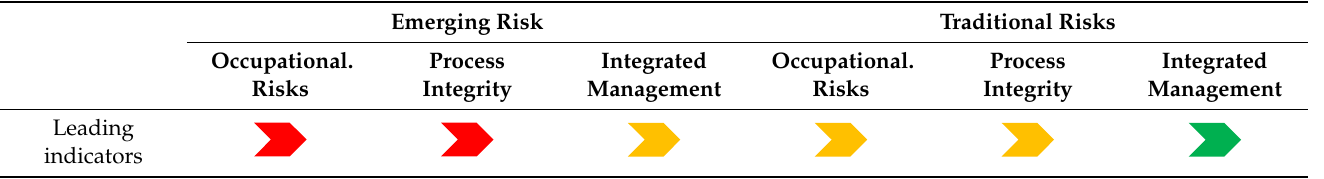
Figure 3. Classification of indicators (Own elaboration). Table 5. Classification of leading indicators (Own elaboration).